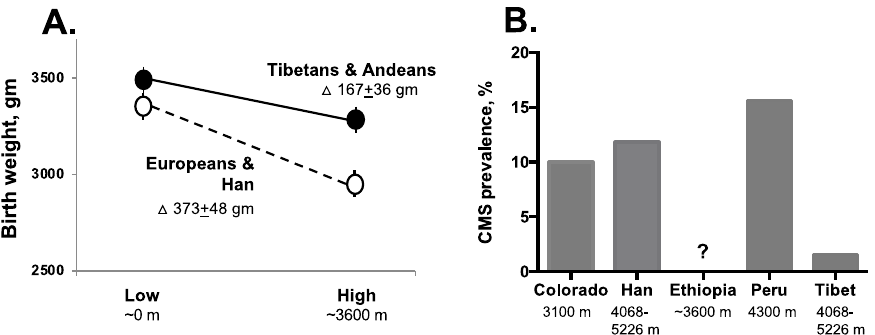
Figure 3. A. Tibetans and Andeans have approximately half the altitude-associated reduction in infant birth weight compared with Europeans or Han Chinese (see text for details and [78] for original references). B : prevalence of chronic mountain sickness (CMS) is markedly less in Tibetans than similarly aged men from various ancestry groups residing at the altitudes shown. [Adapted from Niermeyer et al. [78] with permission from SAGE Publications.].